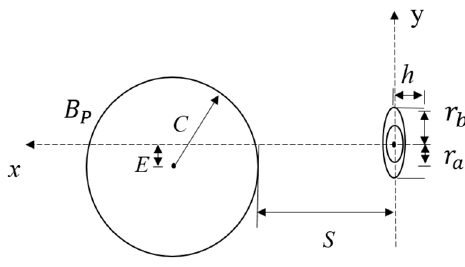
Figure 2. The simplified eccentric analytical model.